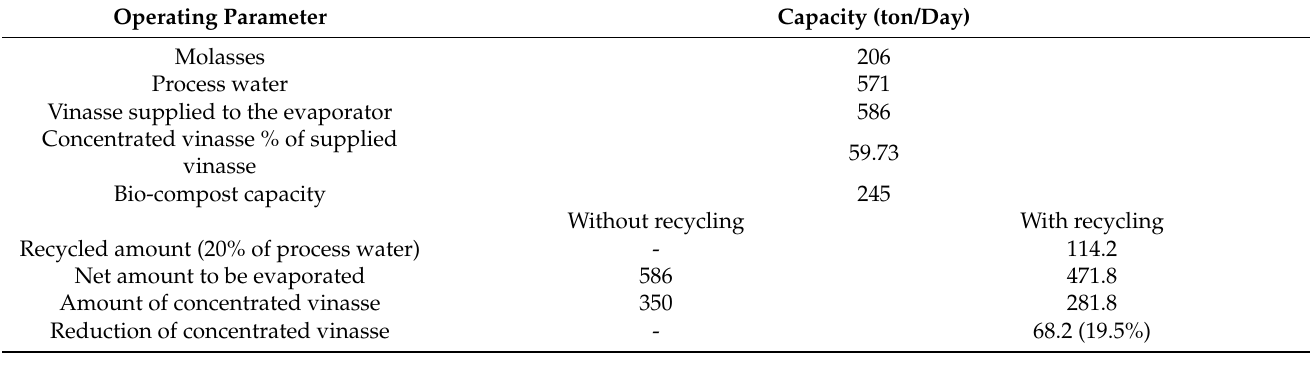
8 of 10 Table 3. Water balance with 20% vinasse recycling. Operating Parameter